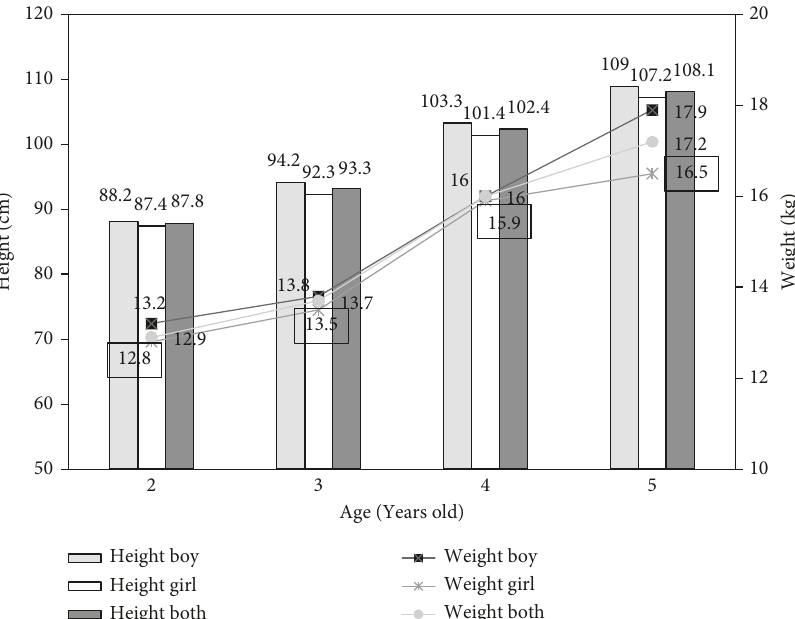
Figure 1: Average height (bars) and weight (lines) by sex and age of preschool children. The data for both sexes are presented with standard deviations. Table 2: Nutritional status of children. Nutritional status of children based on